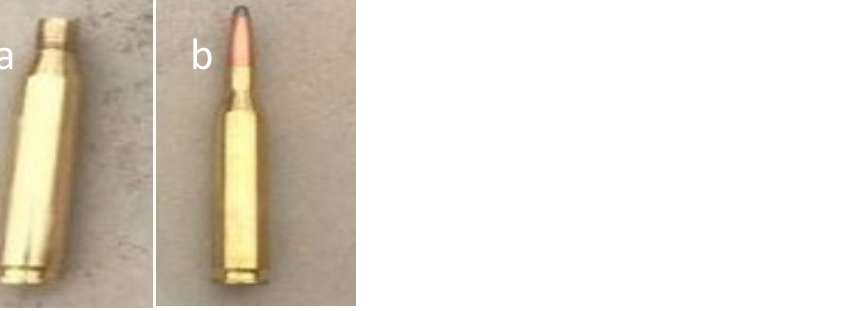
Figure 2. ( a , b ). Bullet (30.06 rifle; 150 g) used for rifle thorax shot killing (traditional hunting).